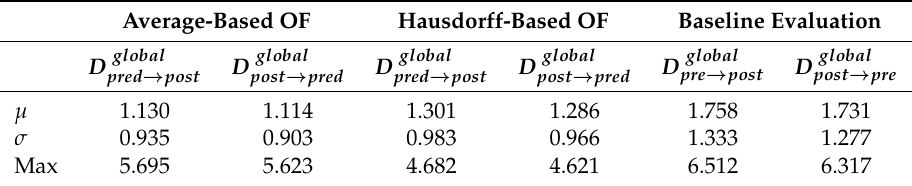
Table 14. Numerical evaluation: Global distances (in mm) between predicted PCLs and post-surgery models using MOR. The training set is sampled with rate of 65% and 75% due to average and Hausdorff OFs,